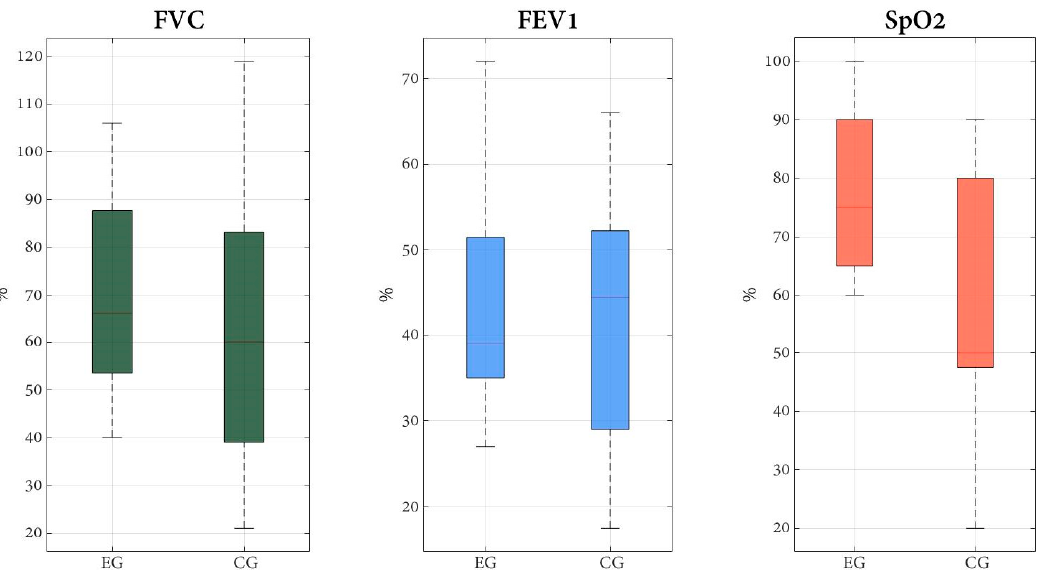
Figure 3. Post intervention comparison of the outcome variables FVC, FEV1, and SpO 2 for the Experimental Group (EG) and the Control Group (CG).